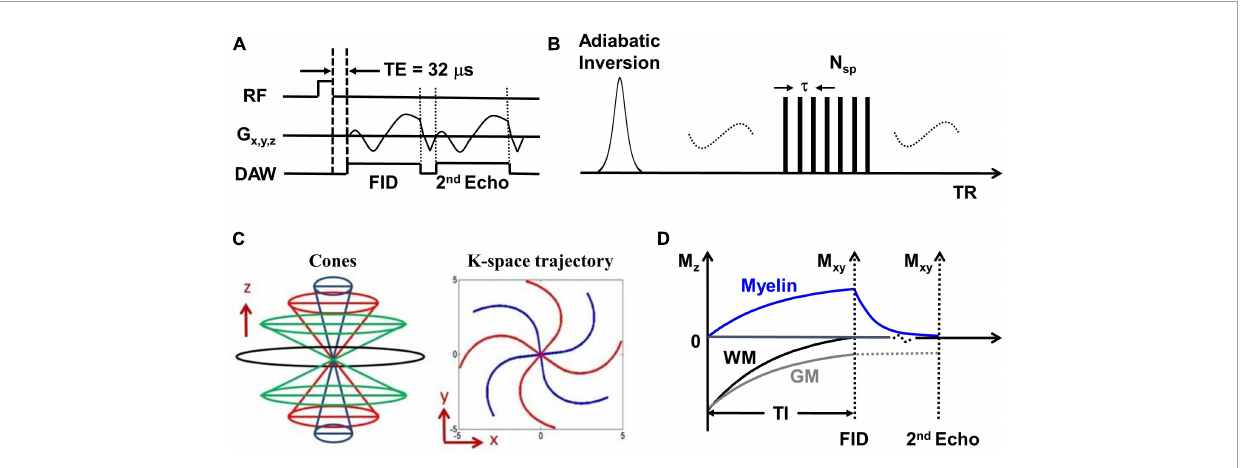
FIGURE1 (A) The basic 3D UTE sequence employs a short rectangular pulse for signal excitation followed by dual-echo spiral cones sampling. (B) The data acquisition scheme where each adiabatic inversion recovery preparation is followed by multi-spoke (Nsp) UTE data acquisitions. (C) The cones data sampling strategy and k-space trajectory. (D) The contrast mechanism in 3D IR-UTE myelin imaging where the long adiabatic inversion pulse inverts and nulls the longitudinal magnetization of long T2 white matter. The myelin magnetization is largely saturated by the adiabatic inversion pulse due to its extremely short T2 and fast relaxation during the long adiabatic inversion process. The saturated myelin magnetization recovers fast during the inversion time (TI) and is selectively imaged by subsequent UTE free induction decay (FID) sampling. Gray matter recovers slower than white matter due to its longer T1. The residual gray matter signal is suppressed by subtracting the 2nd echo image from the first